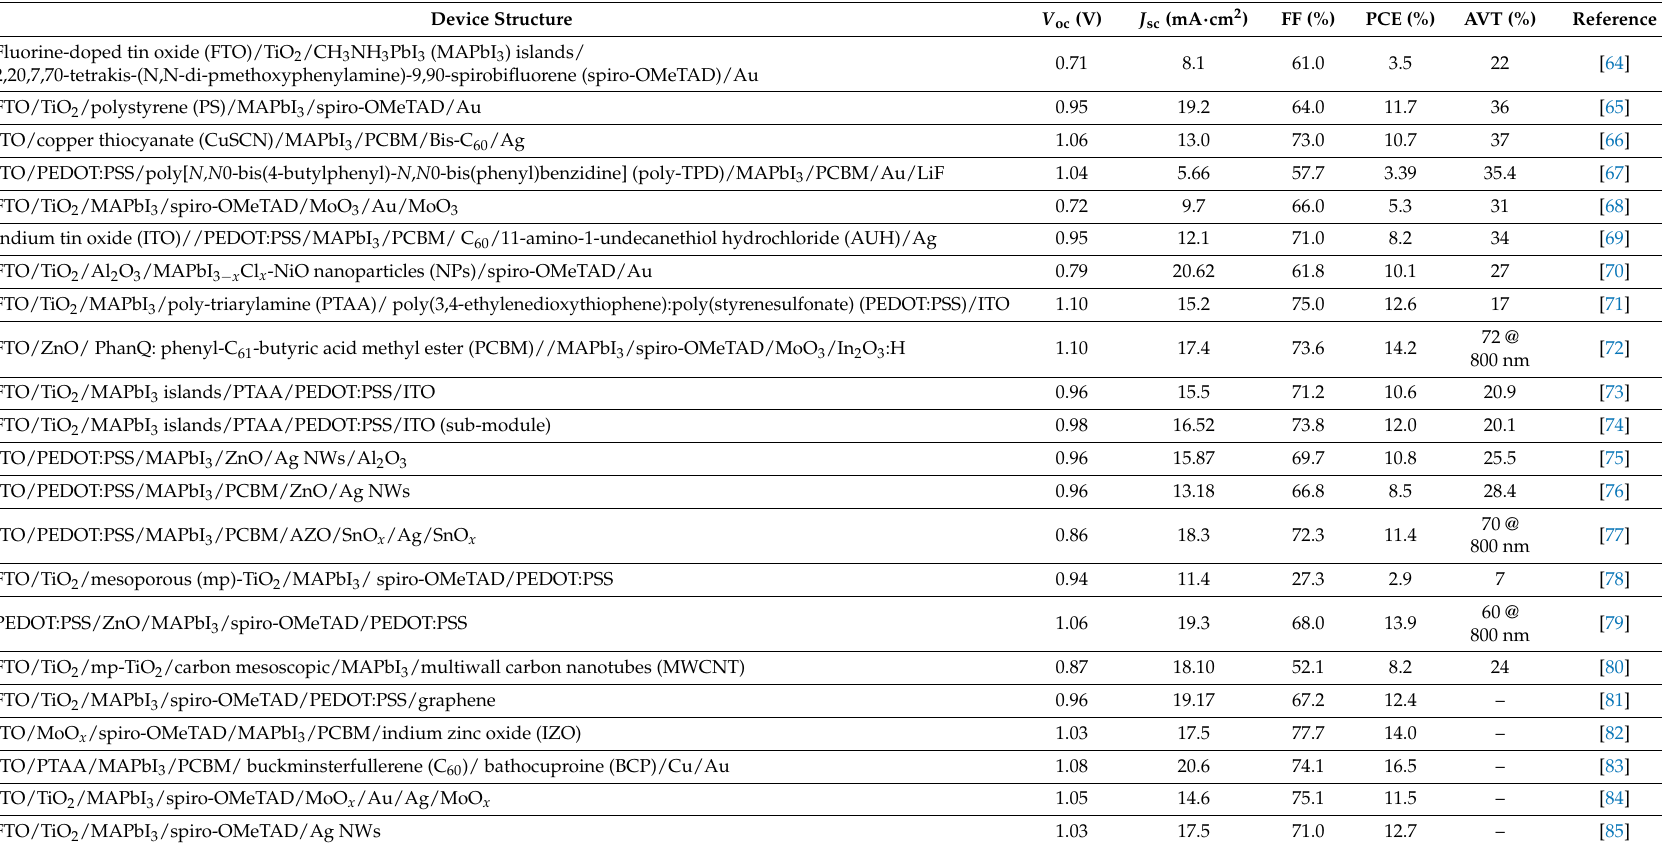
Table 3. Recently-reported photovoltaic parameters of